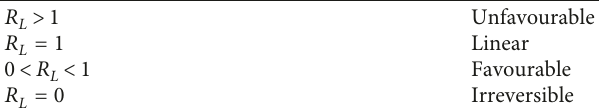
Table 6: Nature of the process depending on the value of the separation factor ( R L )